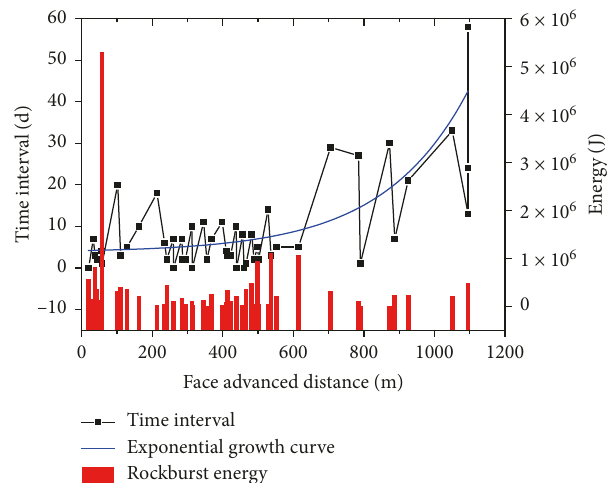
Figure 3: Time interval and the energy of rockbursts regarding the advanced distance of the coalface in Yanbei Coal Mine